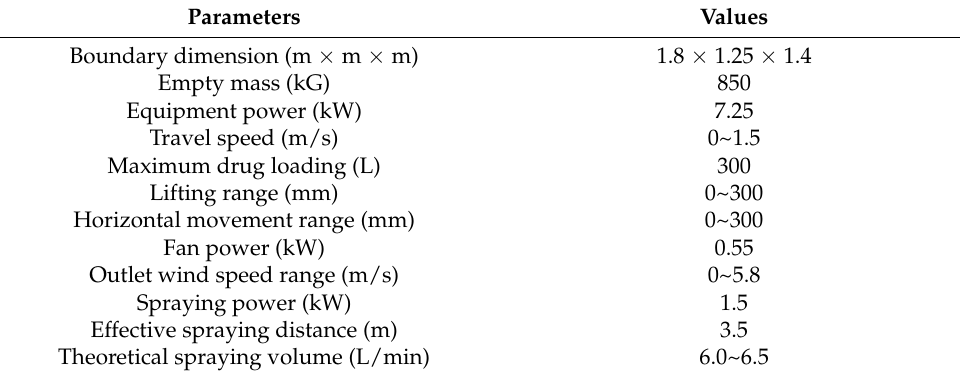
Table 1. Main technical